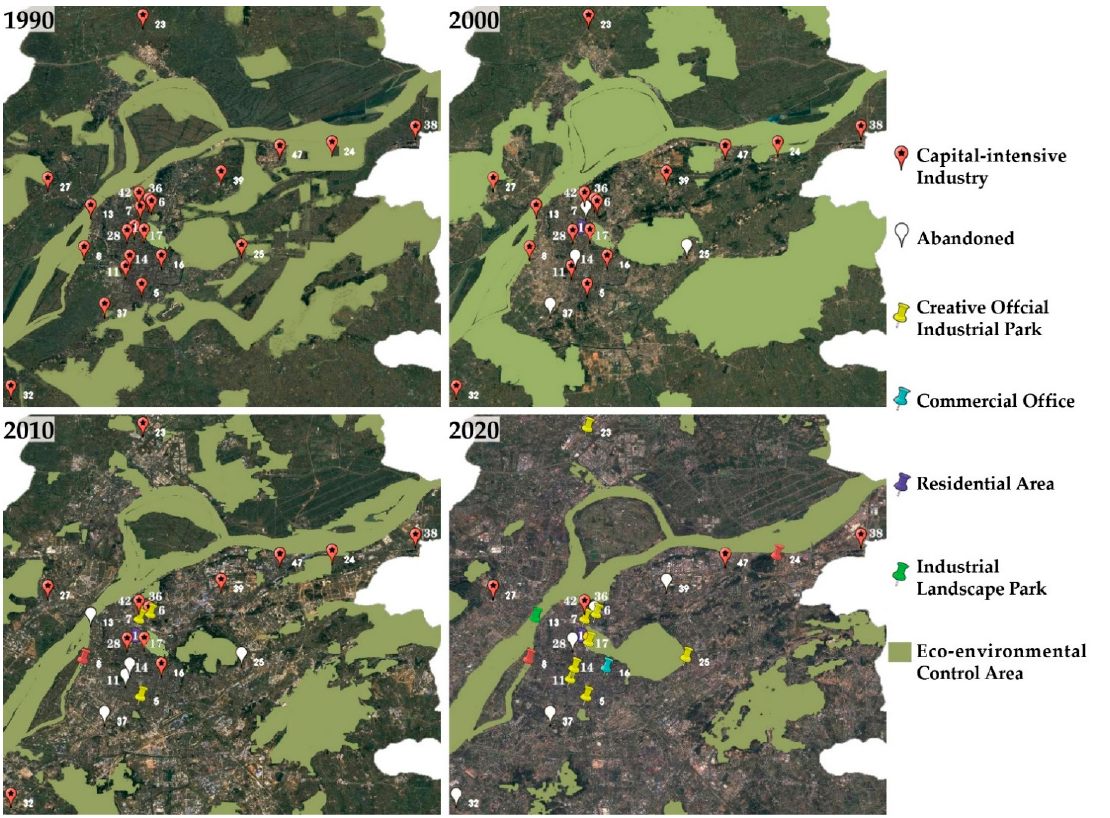
Figure 16. The change in the relationship between the operation state of capital-intensive industries and the eco-environmental control area over time (Figure source: own drawing; data source: on-site investigation and interview).